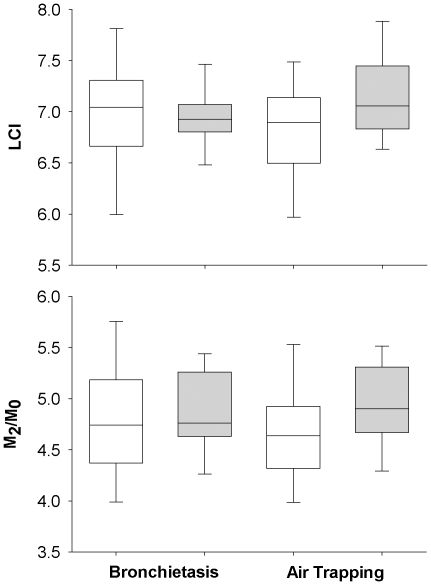
Lung clearance index (LCI; upper panel) and the second moment ratio (M2/M0; lower panel) difference with the presence and absence of bronchiectasis (n = 13 with and n = 36 without bronchiectasis) and air trapping (n = 24 with and n = 25 without air trapping) in infants with cystic fibrosis.Data are presented as box and whisker plots representing the 25th and 75th centiles and 10th and 90th centiles respectively. There were no differences in LCI between those infant with (grey box) and without (white box) lung damage while M2/M0 was significantly increased (p = 0.049) in those infants and young children with air trapping present on chest CT.